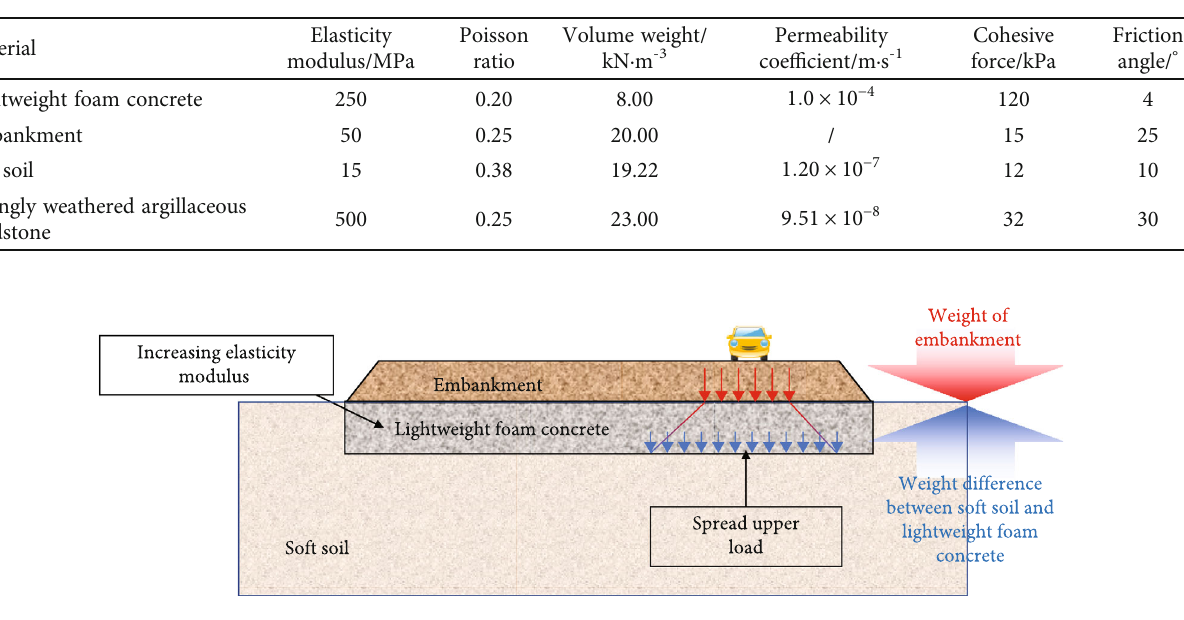
Figure 1: Longitudinal section of engineering geology. Table 1: Parameter values of various materials.